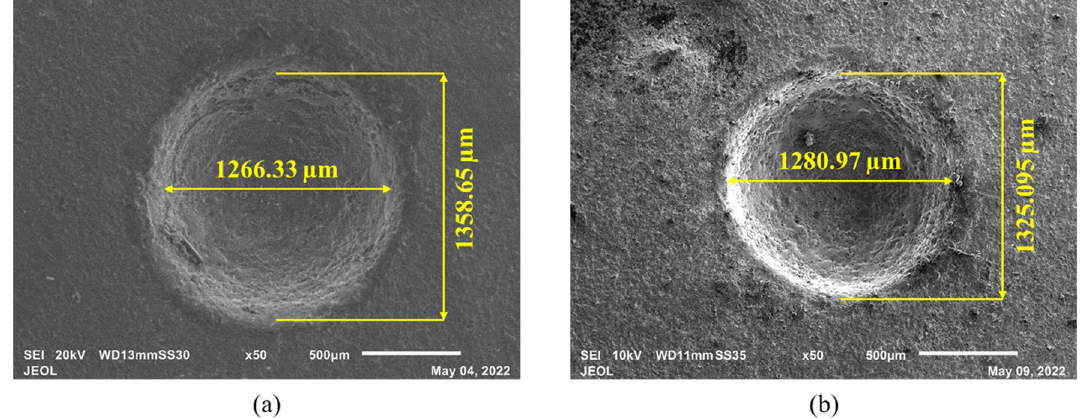
Figure 9. Micrographs of the machined microholes at ( a ) 70 V, 20 wt%, 50% DF and ( b ) 70 V, 30 wt%, 50% DF.